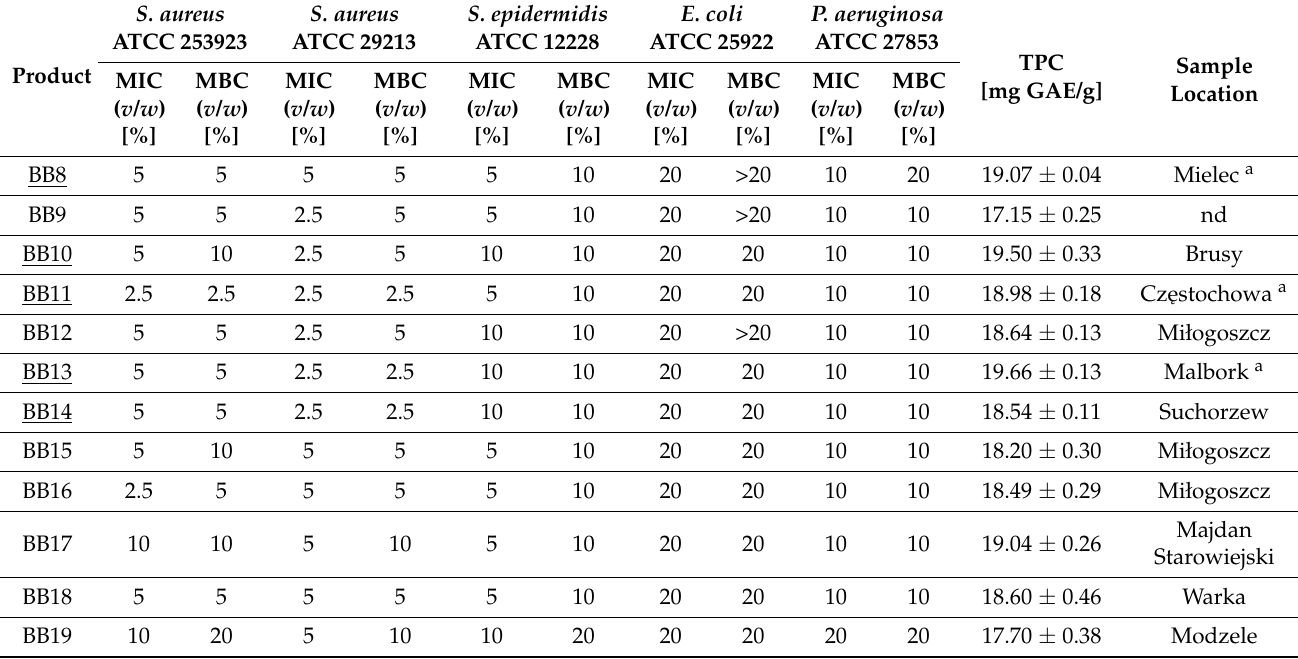
The underlined samples were bought from shops; other samples were provided by beekeepers. “a” indicates that the apiary was located in an area near the presented city (not exactly in the city/urban area). Table 2. Antibacterial activity of selected ethanolic extracts of BP and BB against clinical isolates of Staphylococcus aureus . Isolates 1–6 are methicillin-sensitive and strains 7–9 exhibit the methicillin-resistant